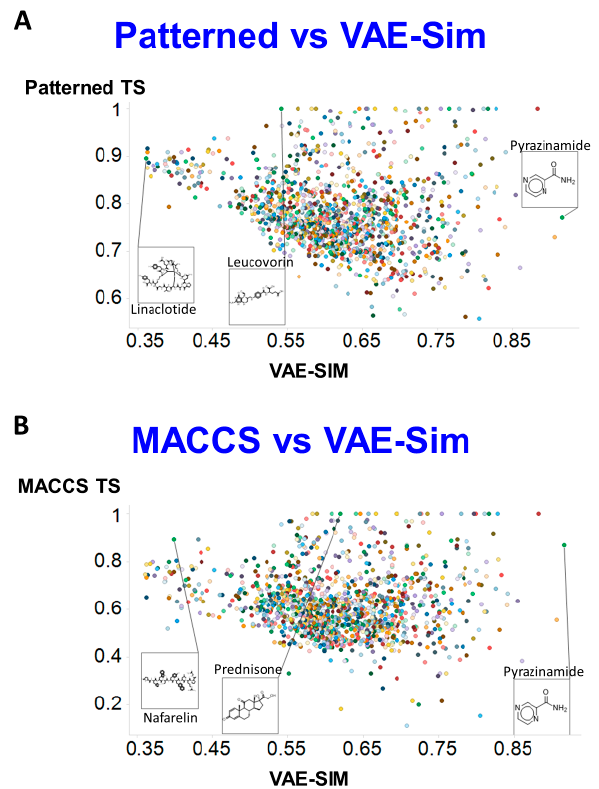
Figure 4. Comparison of similarities between two RDKit fingerprint methods and VAE-Sim Using Tanimoto similarity for fingerprints and Euclidean d 100 similarity for VAE-Sim. ( A ) Patterned encoding. ( B ) MACCS encoding.